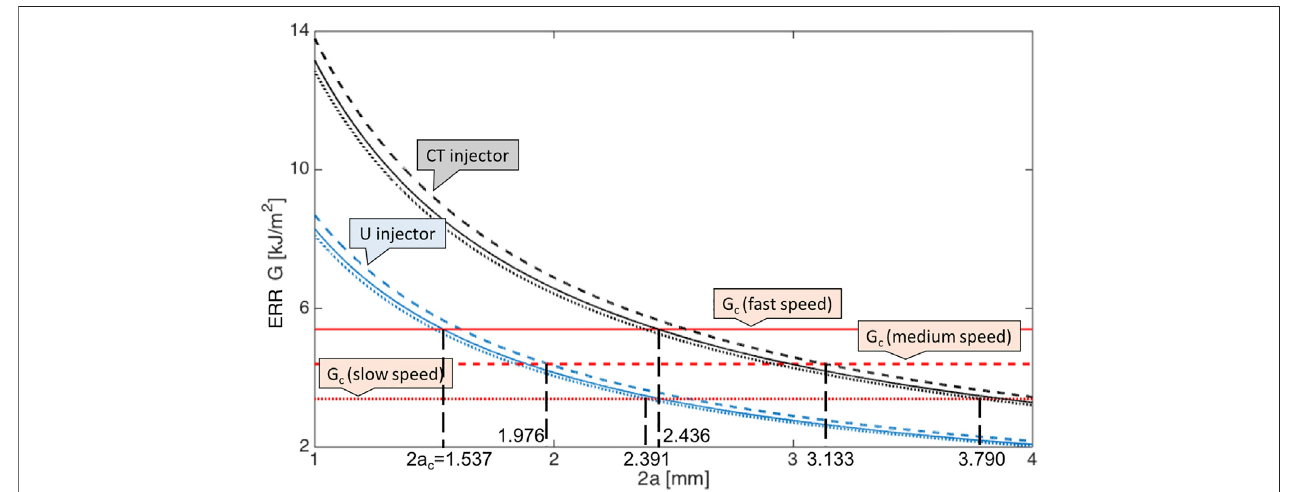
FIGURE 3 | Energy release rates for an isotropic large plate plotted against the incision length 2 a at three incision speeds given CT (black lines) and U injection systems(bluelines).Resultsatfastspeedareinsolidlines,mediumspeedindashedlinesandslowspeedindottedlines.Thecorrespondingcriticalenergyreleaserates G c (red lines) are also given for reference. The six junctions points between same type of lines represent the critical lengths 2 a c .